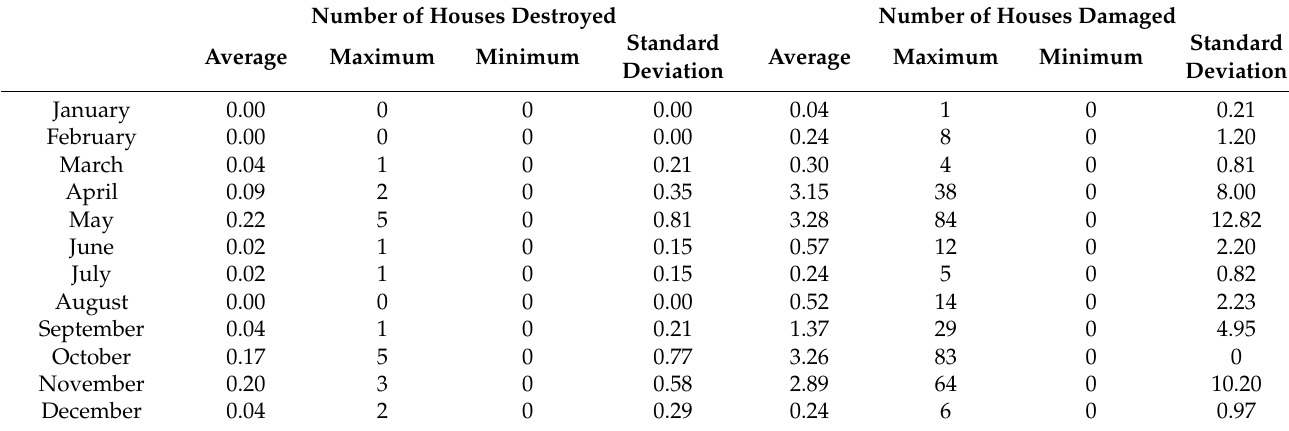
Table 4. Statistics of the monthly variations of deaths and injuries in Sri Lanka due to lightning, from 1974 to 2019. Number of Deaths Number of Injuries Standard Month Average Average Maximum Minimum